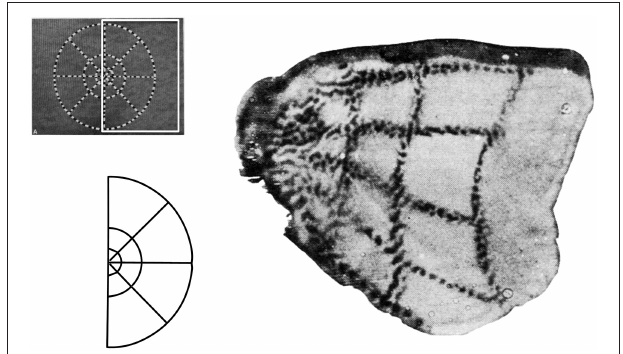
FIGURE 3 | Retinotopic maps are cortical representations of locations on the retina, with some distortions arising from the over-representation of the fovea compared to the periphery. Here this is represented by a use of tracers injected in the retina that then demarcate regions of visual stimulation in the visual cortex. The visual stimulus is shown at the upper left; the white box shows the region of the stimulus that is represented in this area of the brain, with the lower left example showing this shape more clearly. The right image is of the stained cortex that represents this shape. Modified from Tootell et al.